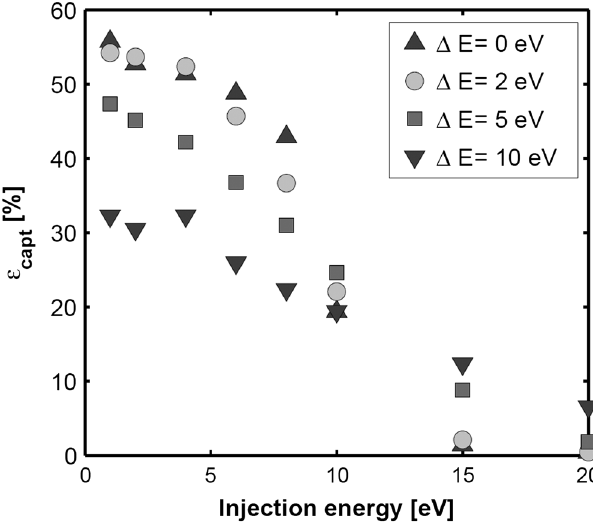
7. Normalized ions captured as a function of the injection energy inside the charge breeder for different values of the injected beam longitudinal energy